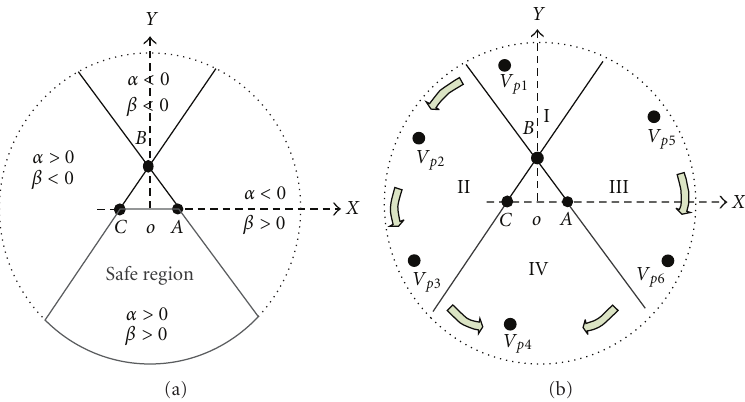
Figure 7: (a) The robot’s workspace can be divided into four parts, considering the sign of α and β . The region where both α and β are positive is called safe region where the robot reaches the goal with no need to pass through the beacons. (b) A set of assumed via points in the workspace; the via points are reached in an order such that the robot is finally located in the safe region.